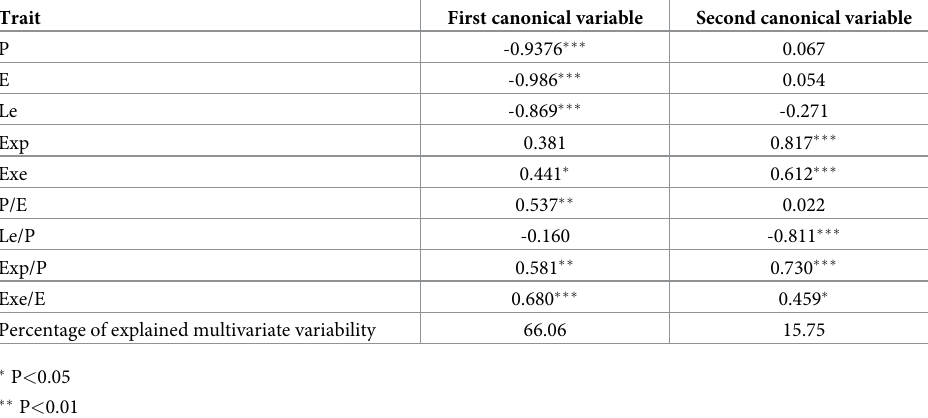
Table 8. Correlation coefficients between the first two canonical variables and original